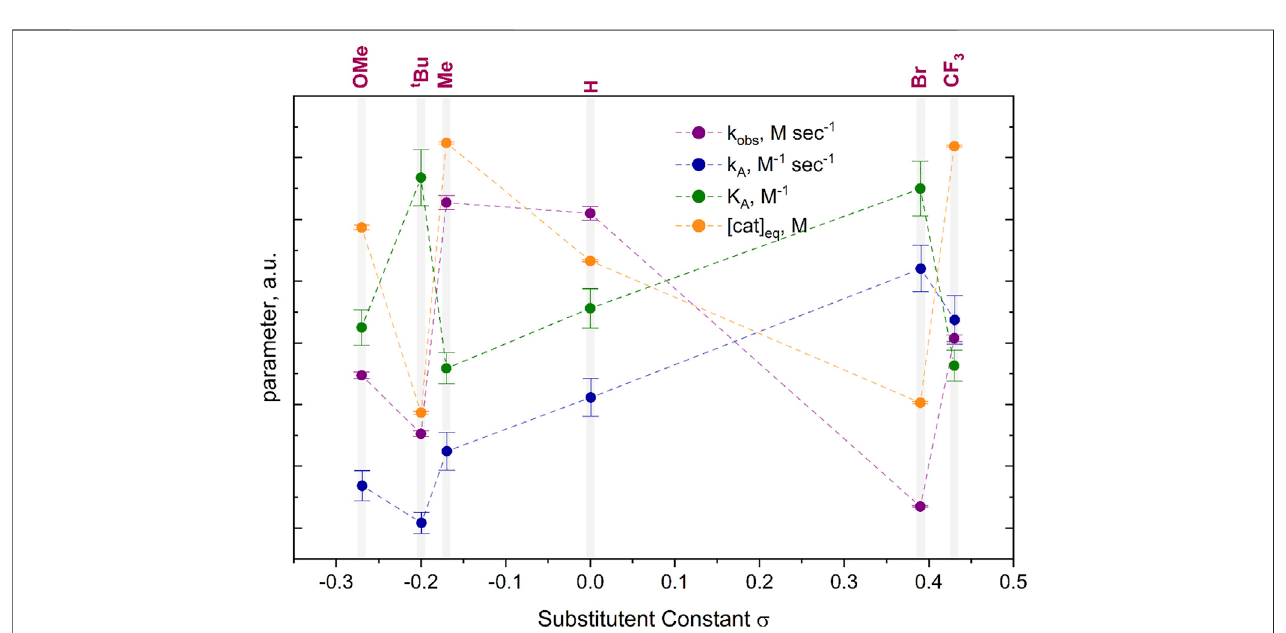
FIGURE7| Kinetic parameters K A, k obs, k A and[cat] eq. wereobtainedfromcyclicvoltammogramand 1 HNMRkineticstudiesforeachofthesixstudiedbismuth(III) acetylides. The electrochemically determined equilibrium constant of the [A · cat] complex formation K A (green) is inversely correlated to the overall rate constant determined by 1 H NMR kinetic experiments of the 5-bismuth(III)-triazolide formation k obs (purple) and equilibrium catalyst concentration [cat] eq. (orange) plotted vs the Hammett sigma values of the six studied para-substituents.